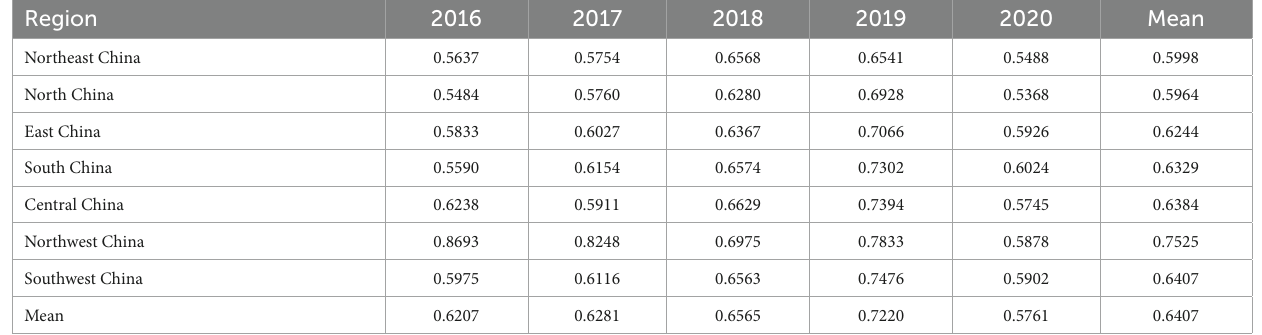
TABLE 3 Average innovation efficiency of listed companies in health industry divided by region.